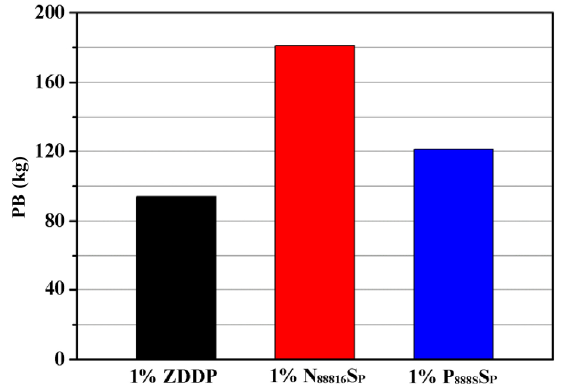
Fig. 7 Maximum non-seizure loads of ZDDP, N88816SP, and P888SSP at mass concentration of 1.0%.